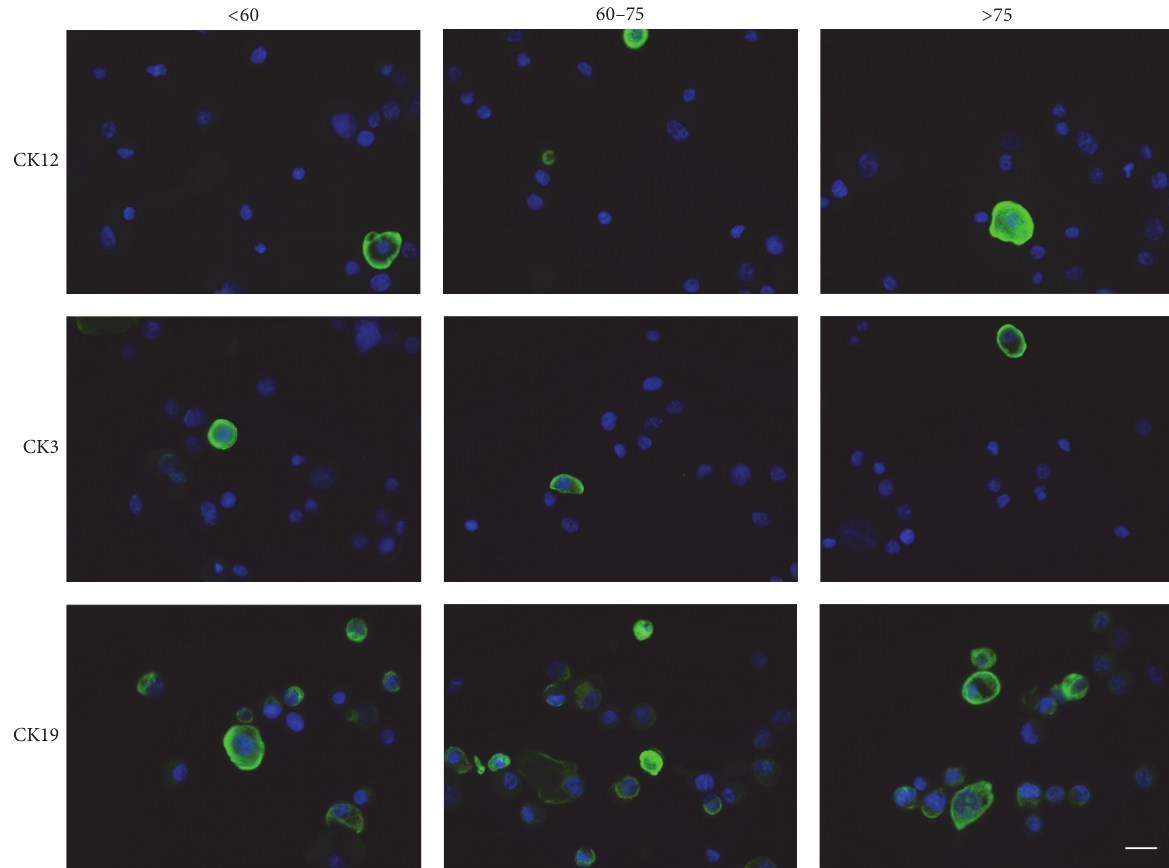
Figure 3: Immunofluorescence for CK12, CK3, and CK19 in LSC pools. Note the lack of expression of CK12 and CK3, with only sparse cells expressing these in certain fields. CK19 was expressed in each condition. Scale bar = 10 𝜇